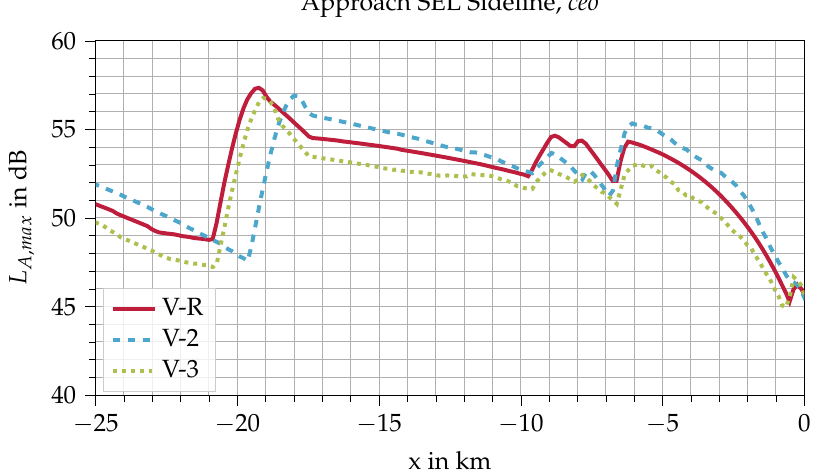
Figure 11. L A , max level 1000m sideline during approach ( ceo ).